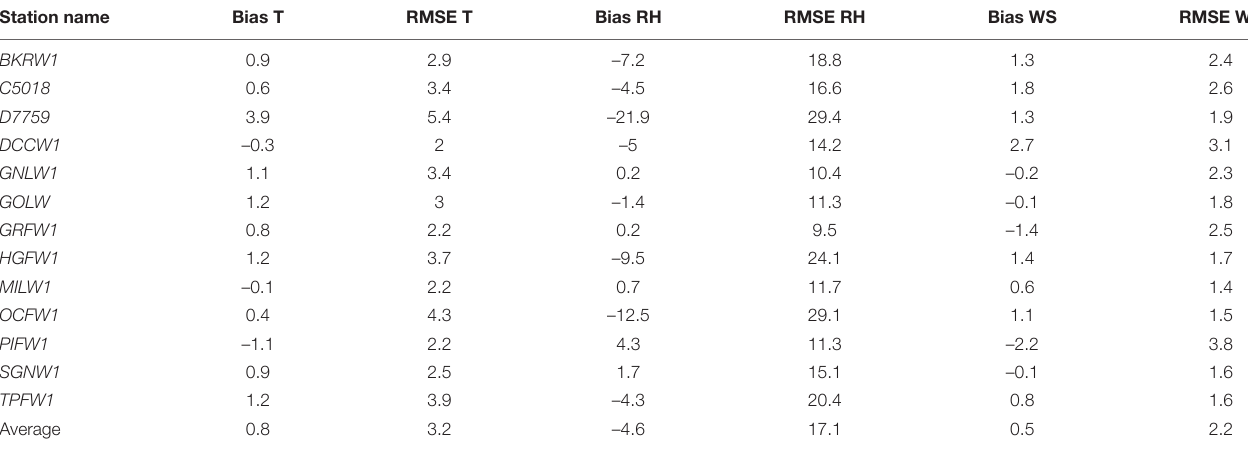
TABLE 3 | WRF-SFIRE meteorological error statistics for weather stations across southern Washington during the 2015 Cougar Creek Fire.